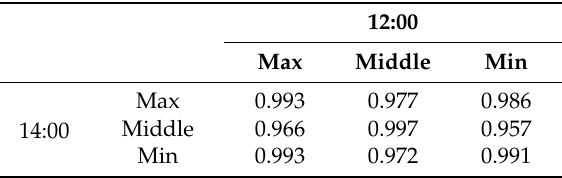
Table 4. The correlation of spectral radiance at 12:00 and